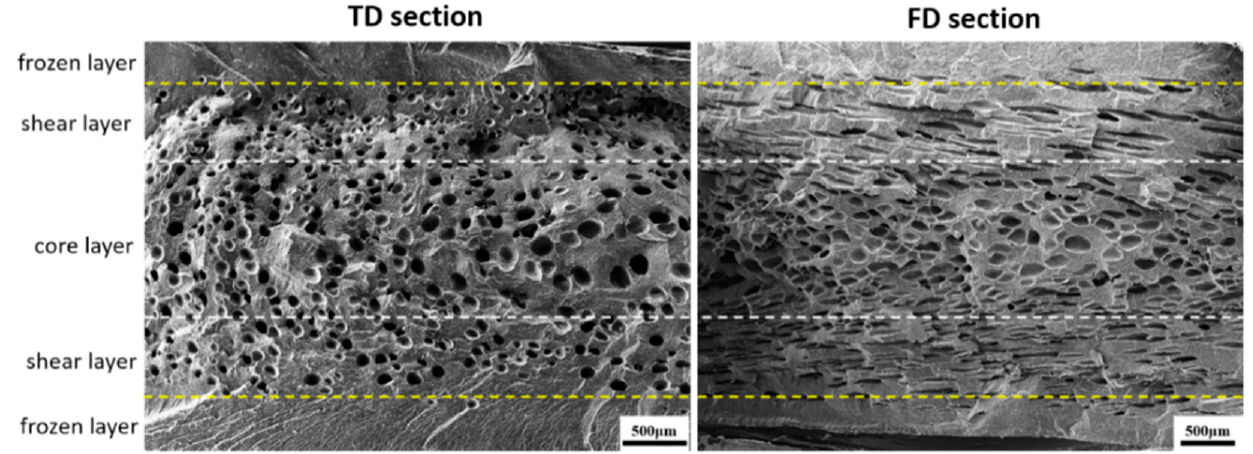
Figure 8. Integral section structure of microcellular PP/PET(F)/POE samples.